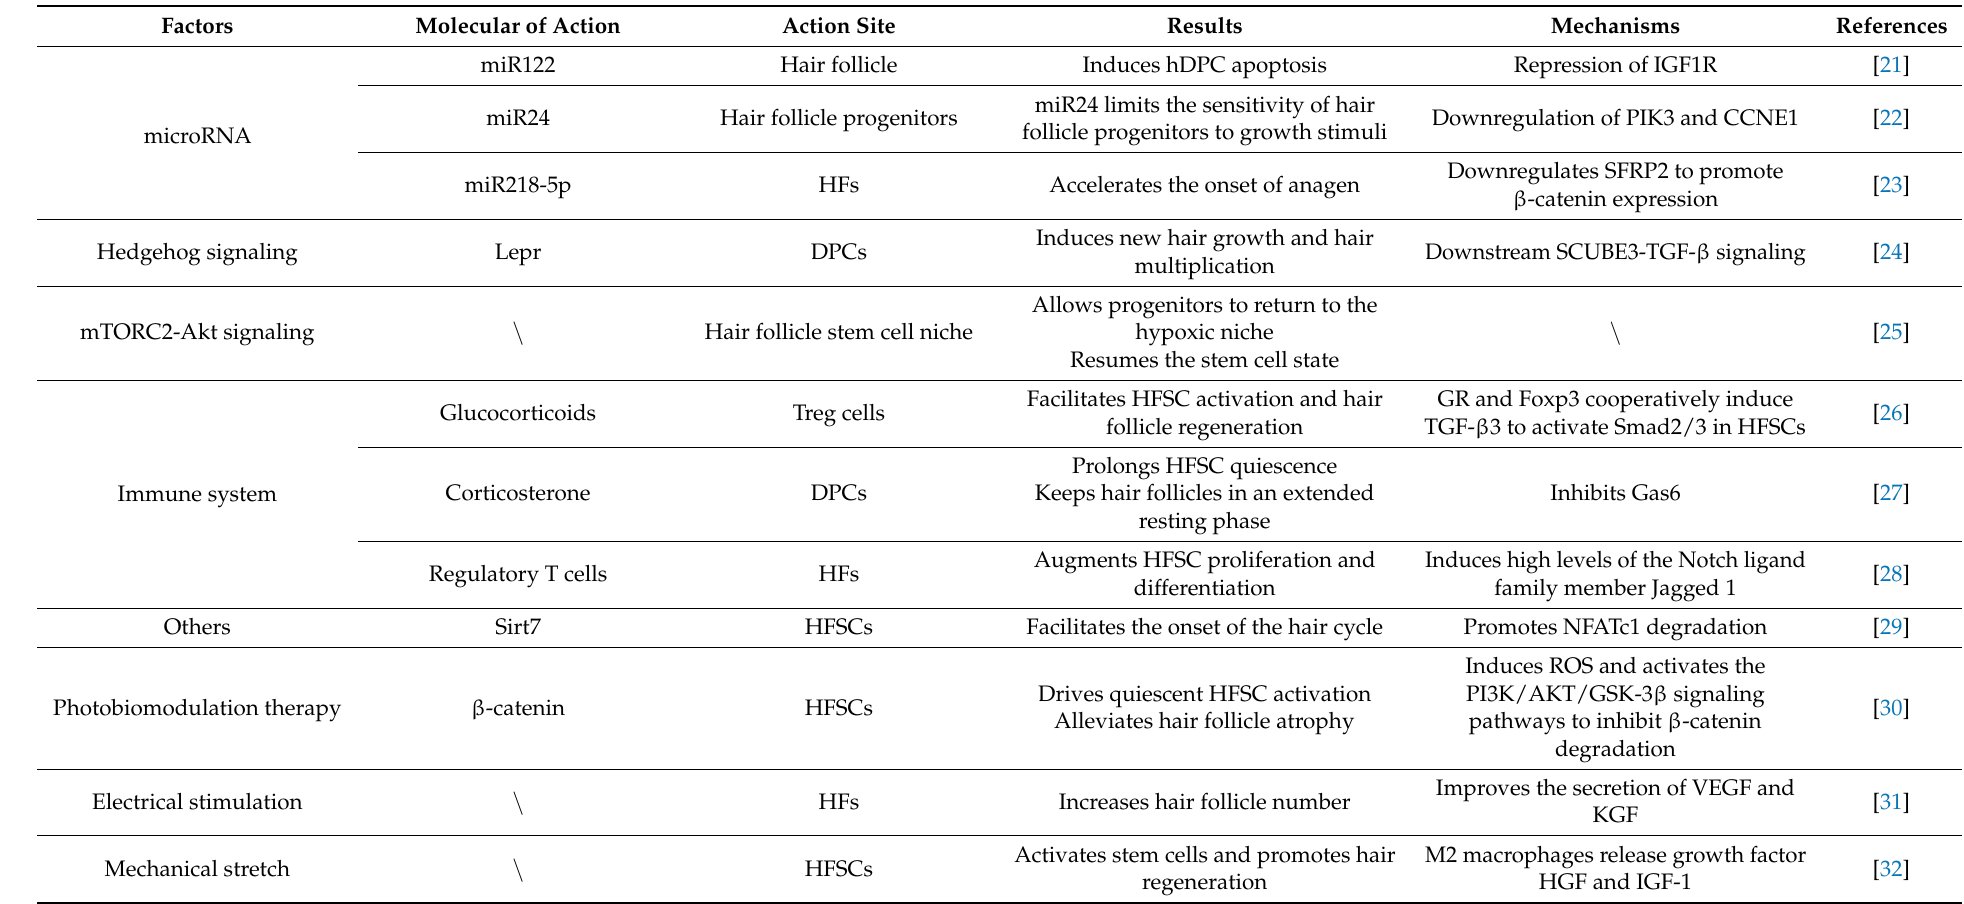
Table 1. Summary of the molecular mechanisms of hair